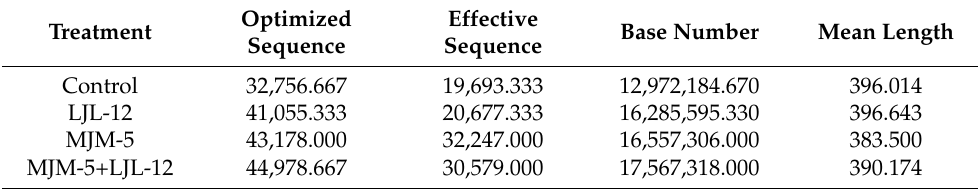
Table 1. Results of 16S rRNA gene high-throughput sequencing of soil bacterial community in the rhizosphere of alfalfa under Control, LJL-12, MJM-5, and MJM-5+LJL-12 treatments. Treatment